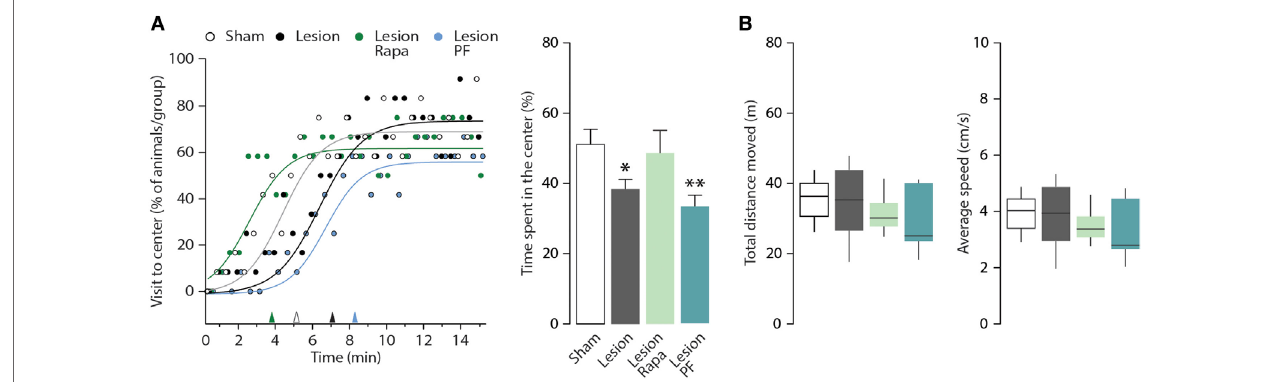
FigUre 3 | Rapamycin counteracts thigmotaxis in a mouse model of Parkinson’s disease. Open field (OF) performance of Sham ( n = 12), and Lesion mice treated with vehicle ( n = 12), rapamycin (Lesion Rapa, n = 12), or PF-4708671 (Lesion PF, n = 12) during the 15-min test. (a) Left panel shows the percentage of animals that visited the center of the OF, expressed as time course. The performance is graphed as 30-s time points (circles) and best-fitting curves. Triangles on the x -axis indicate the latency (min) for 50% of the animals in each group to explore the center zone of the OF. Right panel shows the time spent in the center zone, expressed as percent over the total duration of the test. Data are presented as mean ± SEM. * p = 0.05, ** p = 0.007 vs. Sham (one-way ANOVA followed by Fisher’s post hoc comparison). (B) Tukey whiskers plots with the median, 10th, 25th, 70th, and 90th percentiles showing total distance moved in the OF (m) and average speed (cm/s). One-way ANOVA showed no differences between groups. Groups and treatments are as indicated in